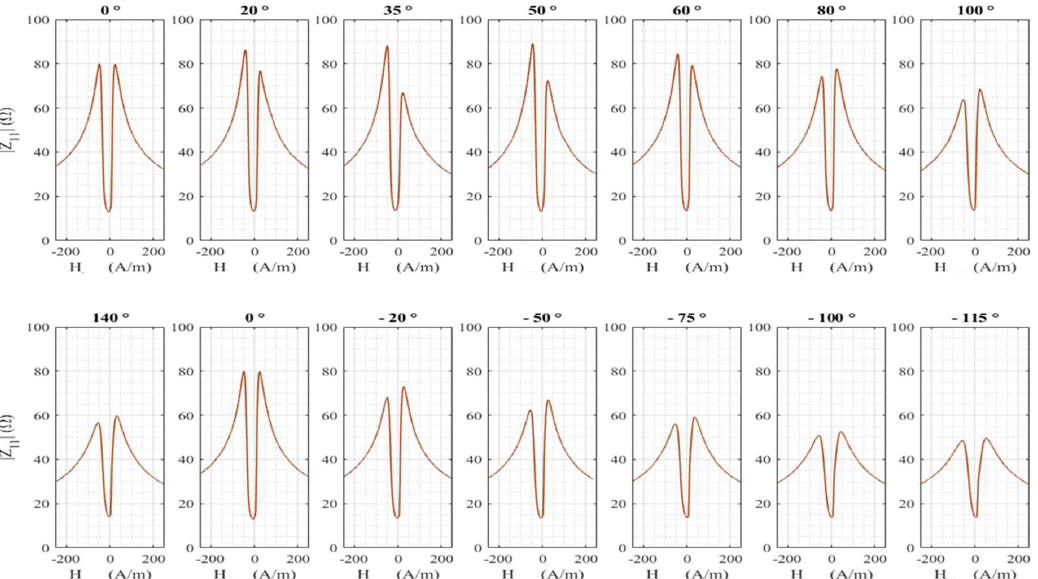
Figure 4. Modulus of the diagonal component for different rotation angles of the sensitive element.